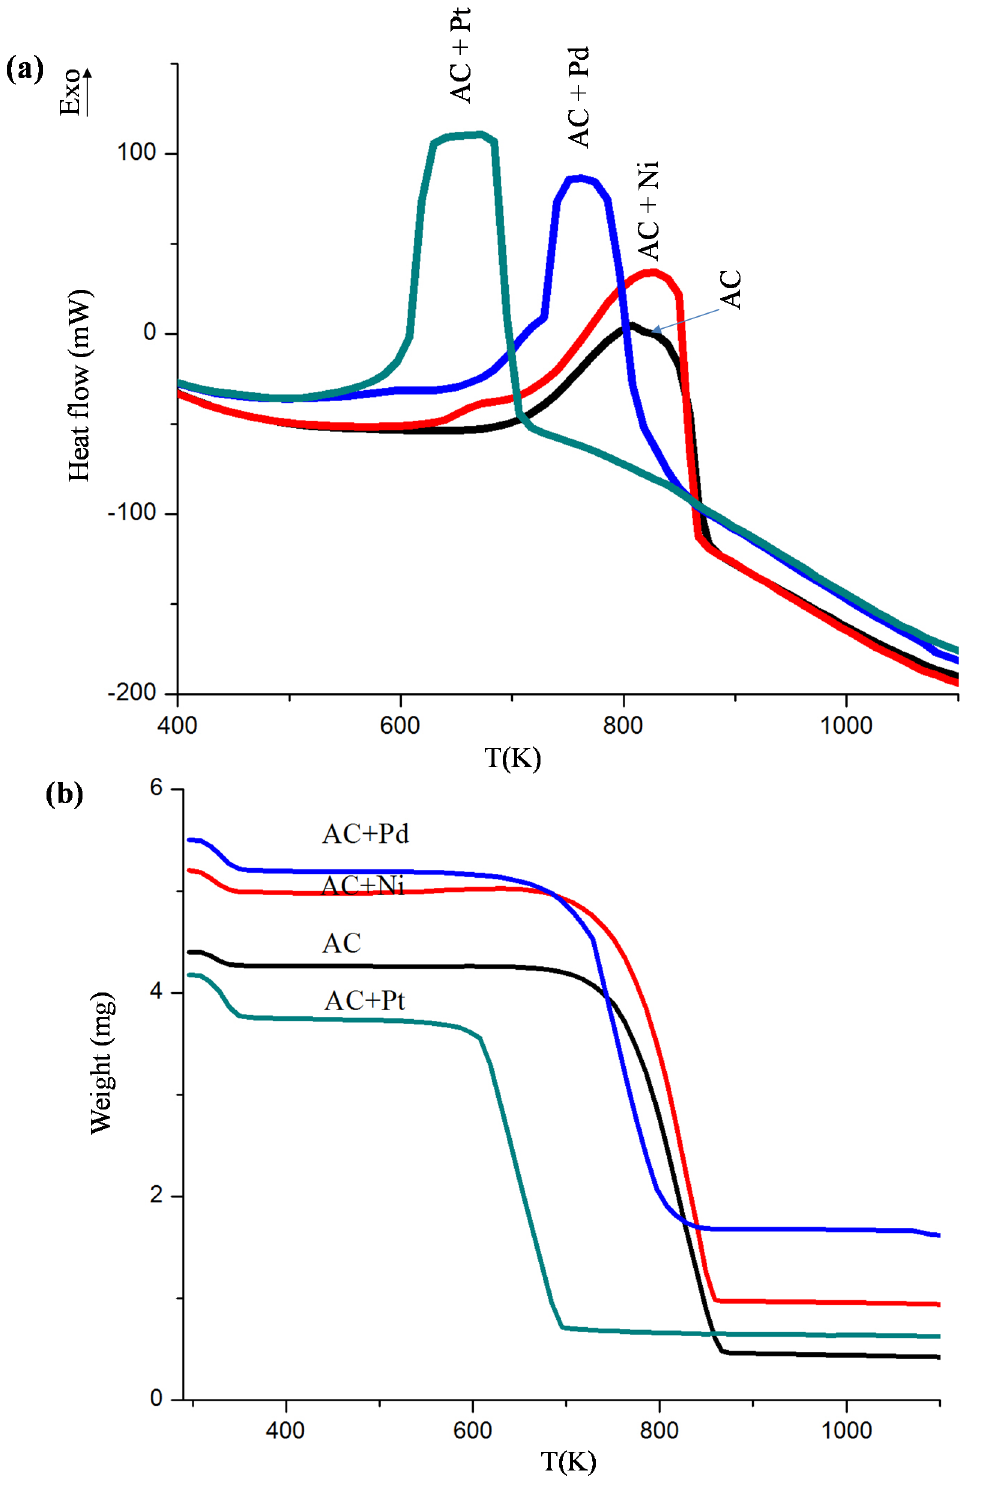
Figure 5. ( a ) DSC analysis under air flow of activated carbon (AC) and metal-anchored AC + Ni, AC + Pd and AC + Pt, and ( b ) TGA analysis under air flow of AC and metal-anchored AC + Ni, AC + Pd and AC +